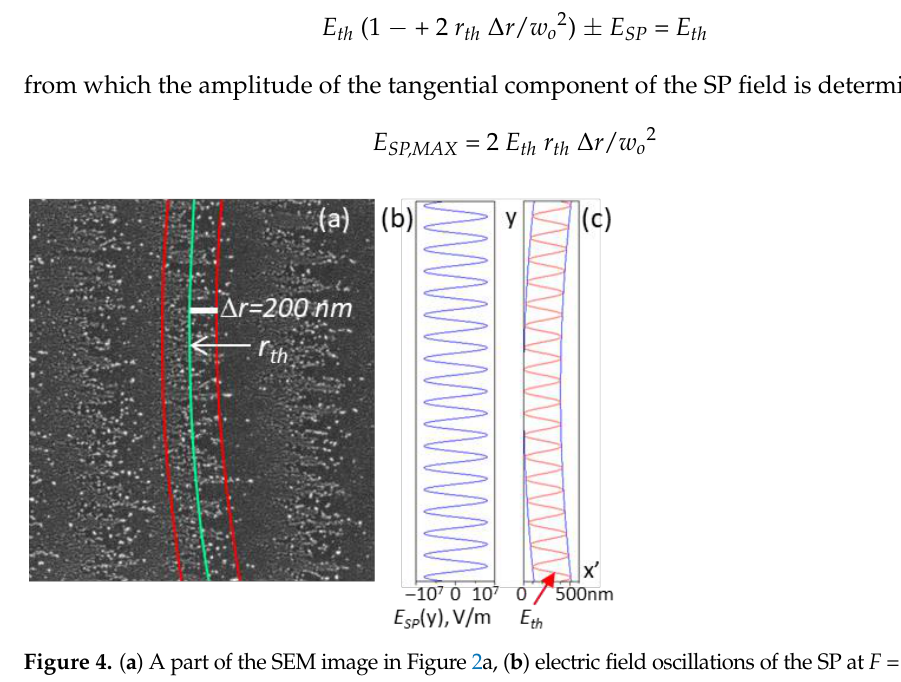
Figure 4. ( a ) A part of the SEM image in Figure 2a, ( b ) electric field oscillations of the SP at F = 0.21 J/cm 2 , and ( c ) E th = const is the equi-field sinusoid curve corresponding to the ablation (spallation) threshold inside the groove fabricated at F = 0.21 J/cm 2